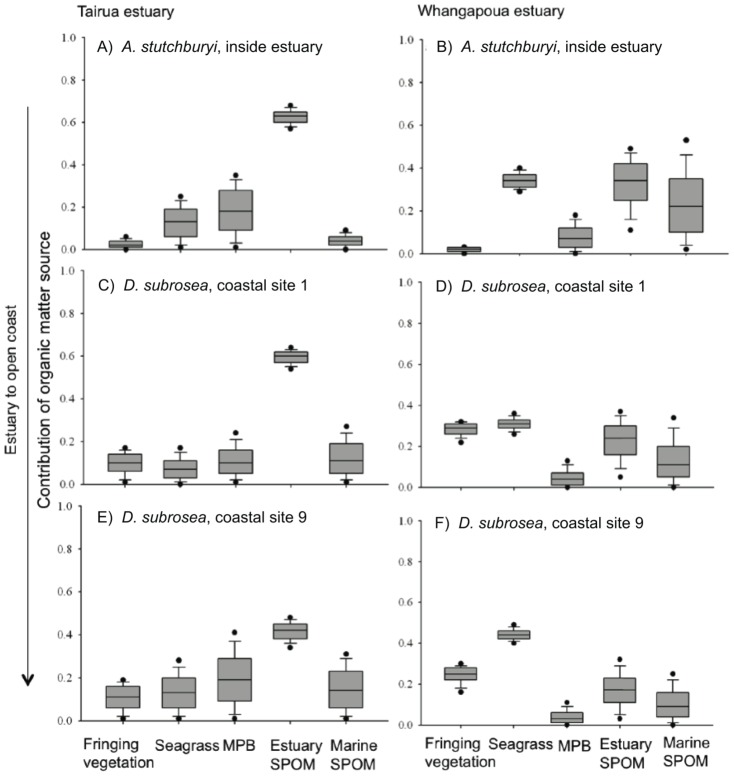
Mixing model outputs showing the range of the potential contribution (0.0 to 1.0 representing 0% to 100%) of different primary producers to venerid bivalves, Austrovenus stutchburyi inside the estuaries and Dosinia subrosea, on the open coast at Tairua (left) and Whangapoua (right) estuaries.The shaded boxes represent the 75th (top) to 25th (bottom) percentiles with the central lines indicating the median. The vertical lines outside the boxes indicate the 95th (top) and 5th (bottom) percentiles. MPB = microphytobenthos.